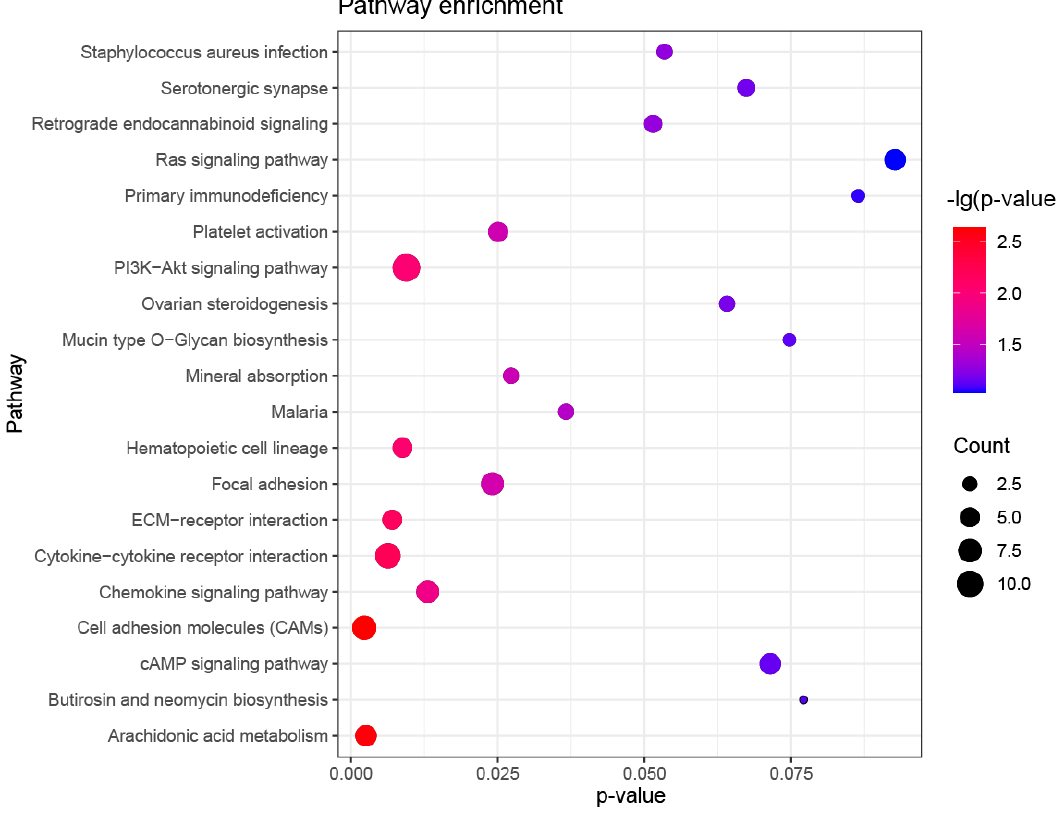
Figure 9. The top 20 pathways with the highest enrichment degree of up-regulated and down-regulated genes.